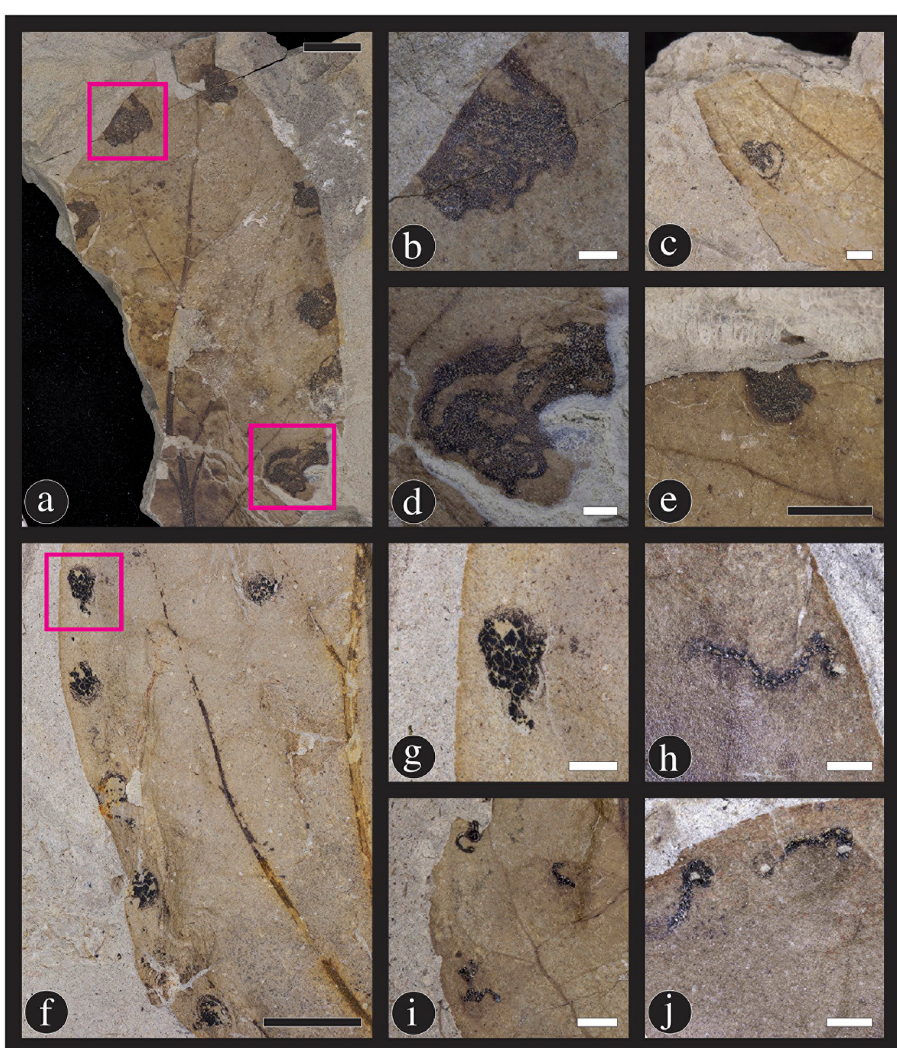
Fig 15. New leaf mine damage type on Catula gettyi . DT332 includes a range of leaf mine shapes, including (A) roughly circular mines with serpentine trajectories visible within the mine (DMNH 39726), close up of mines outlined (B, D); (E) leaf mines with a circular chamber and no evident serpentine trails (DMNH 41587); (C) a linear phase followed by a solid, circular chamber (DMNH 47126), (F) (DMNH 39737), close up of mine outlined (G,I) (DMNH 41597); and (H) (DMNH 41597), (J) (DMNH 41597) mines with linear trajectories. Differences in mine form are likely attributable to the number of instars completed by each individual. These mines are typically found along the margin of C . gettyi leaves. Black scale bars = 5 mm; white scale bars = 1